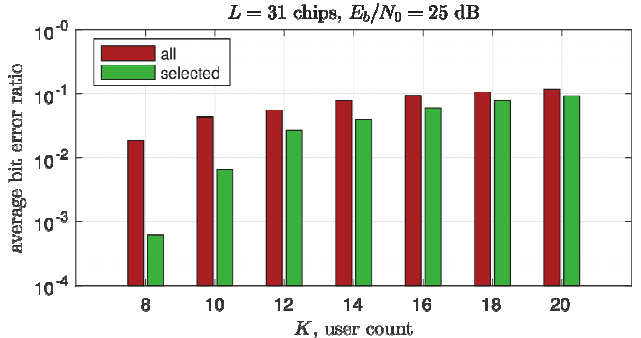
Fig. 11. Asynchronous DS-CDMA: BER levels for selected and all 31-chip- long sequences generated by logistic map at SNR per bit at a level of 25 dB.